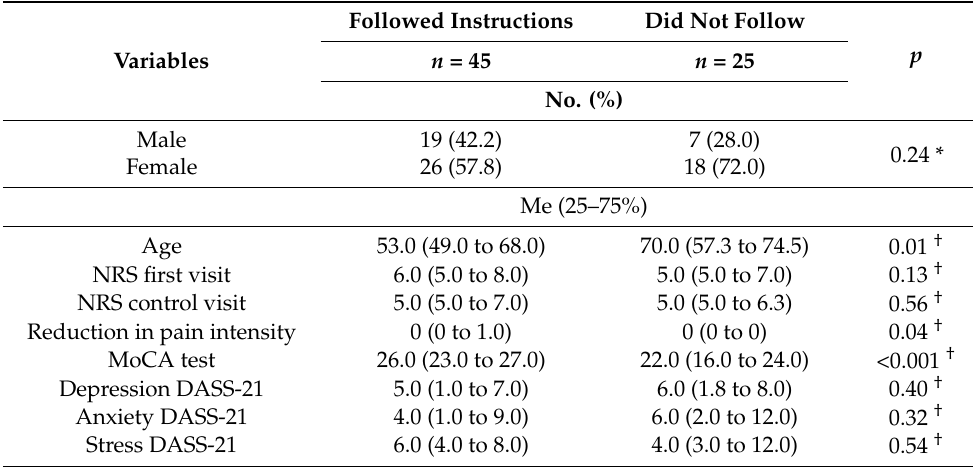
Table 2. Comparison between patients regarding adherence to pharmacotherapy.